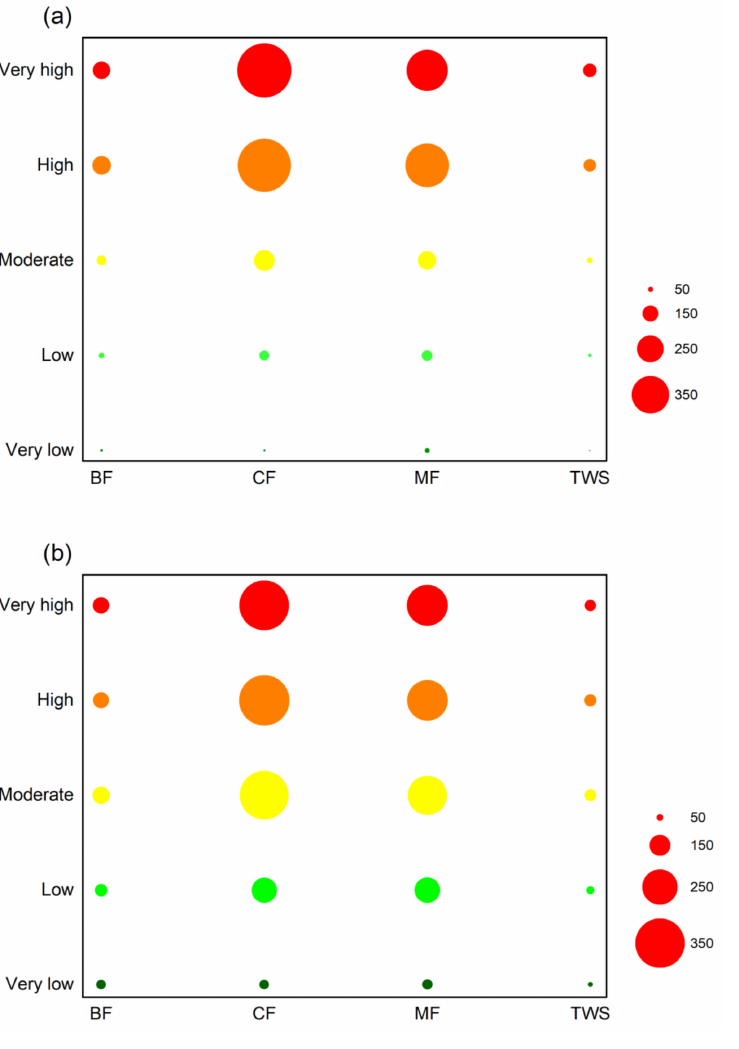
Figure 6. Forest fire distribution across vegetation and occurrence probability classes defined by the ( a ) GBM and ( b ) RF